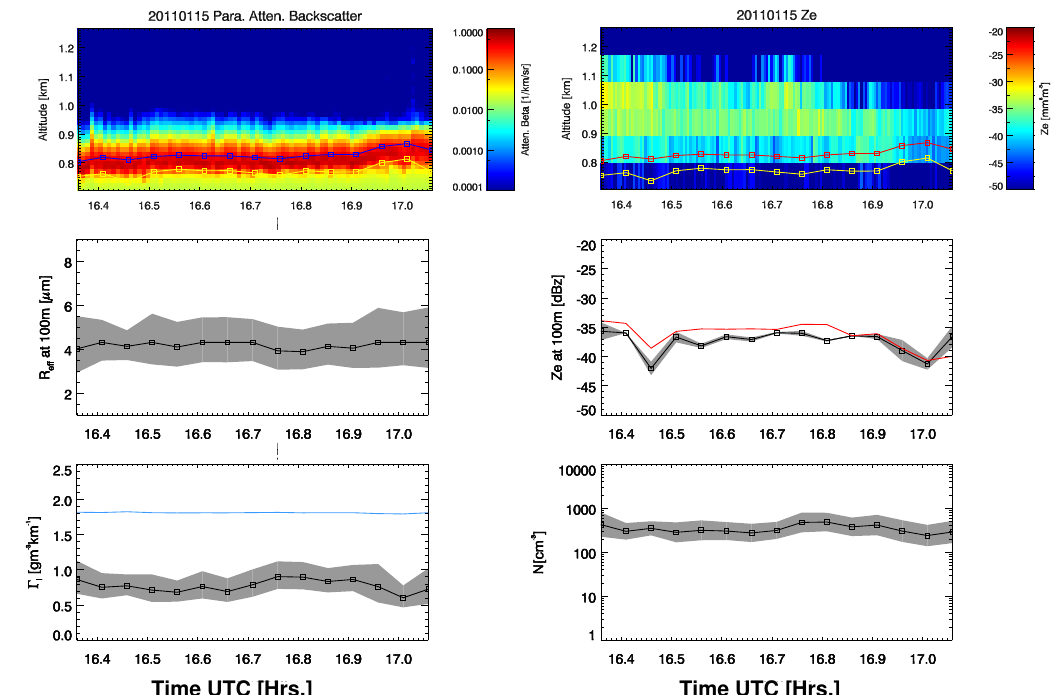
Figure 15. Retrieved time series of R eff,100 , (cid:48) l and N for 15 January 2011 from about 16.4 to 17.1UTC. The light-blue line in the (cid:48) l plot indicates the adiabatic limit at cloud base. The black line in the Z e panel shows the reflectivity predicted by Eq. (35) corresponding to the first 100m radar bin fully above the estimated cloud base while the red line shows the corresponding actual radar observed value. The radar calibration uncertainty (not indicated) is thought to be in the range of